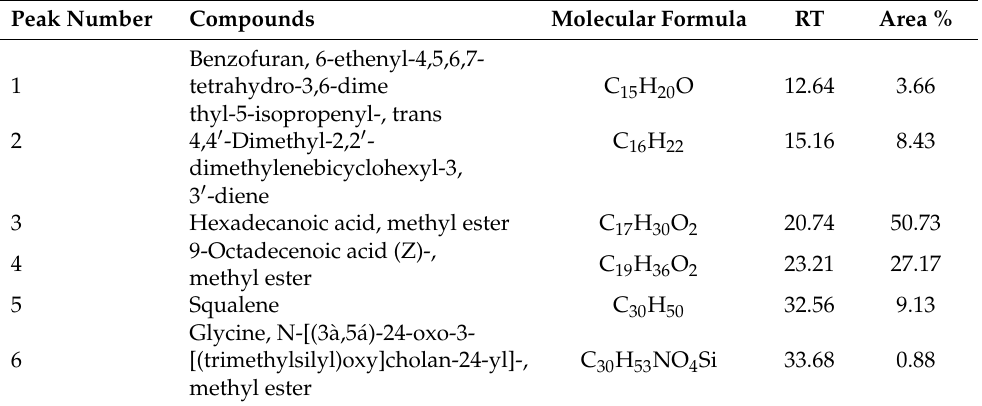
Table 2. Fatty acids and fatty acid methyl esters molecular formula, RT, and area (%) in palm oil. Peak Number